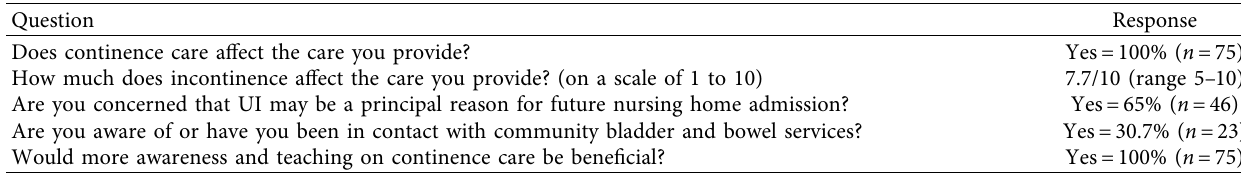
Table 3: Responses of carers to question items.